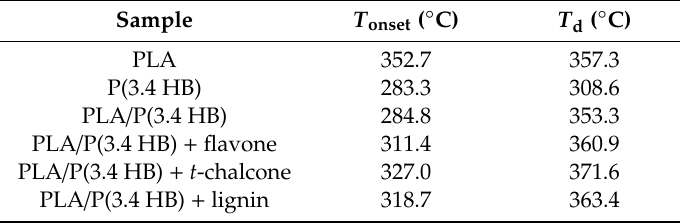
Figure 3. DTG curves of PLA / P(3.4 HB) composites with selected natural antioxidants in comparison to reference PLA, P(3.4 HB) and PLA / P(3.4 HB) samples. Table 4. DTG results for pure PLA, P(3.4 HB), PLA / P(3.4 HB) blend and PLA / P(3.4 HB) blends with selected natural antioxidants (flavone, trans -chalcone and lignin): temperature of beginning of main decomposing ( T onset ), temperature of the most intensive weight loss ( T d ).